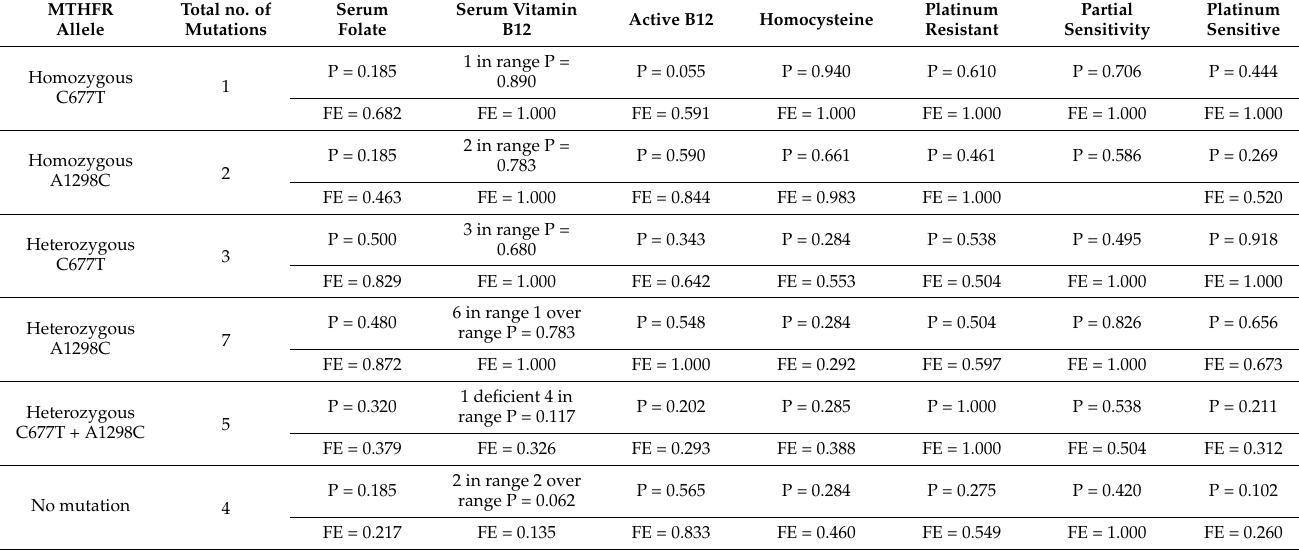
Table 5. MTHFR mutations, pathology and platinum response: using a two-way table of association using Pearson’s chi-squared significance and Fisher’s exact test for association of each MTHFR mutation on blood pathology and platinum